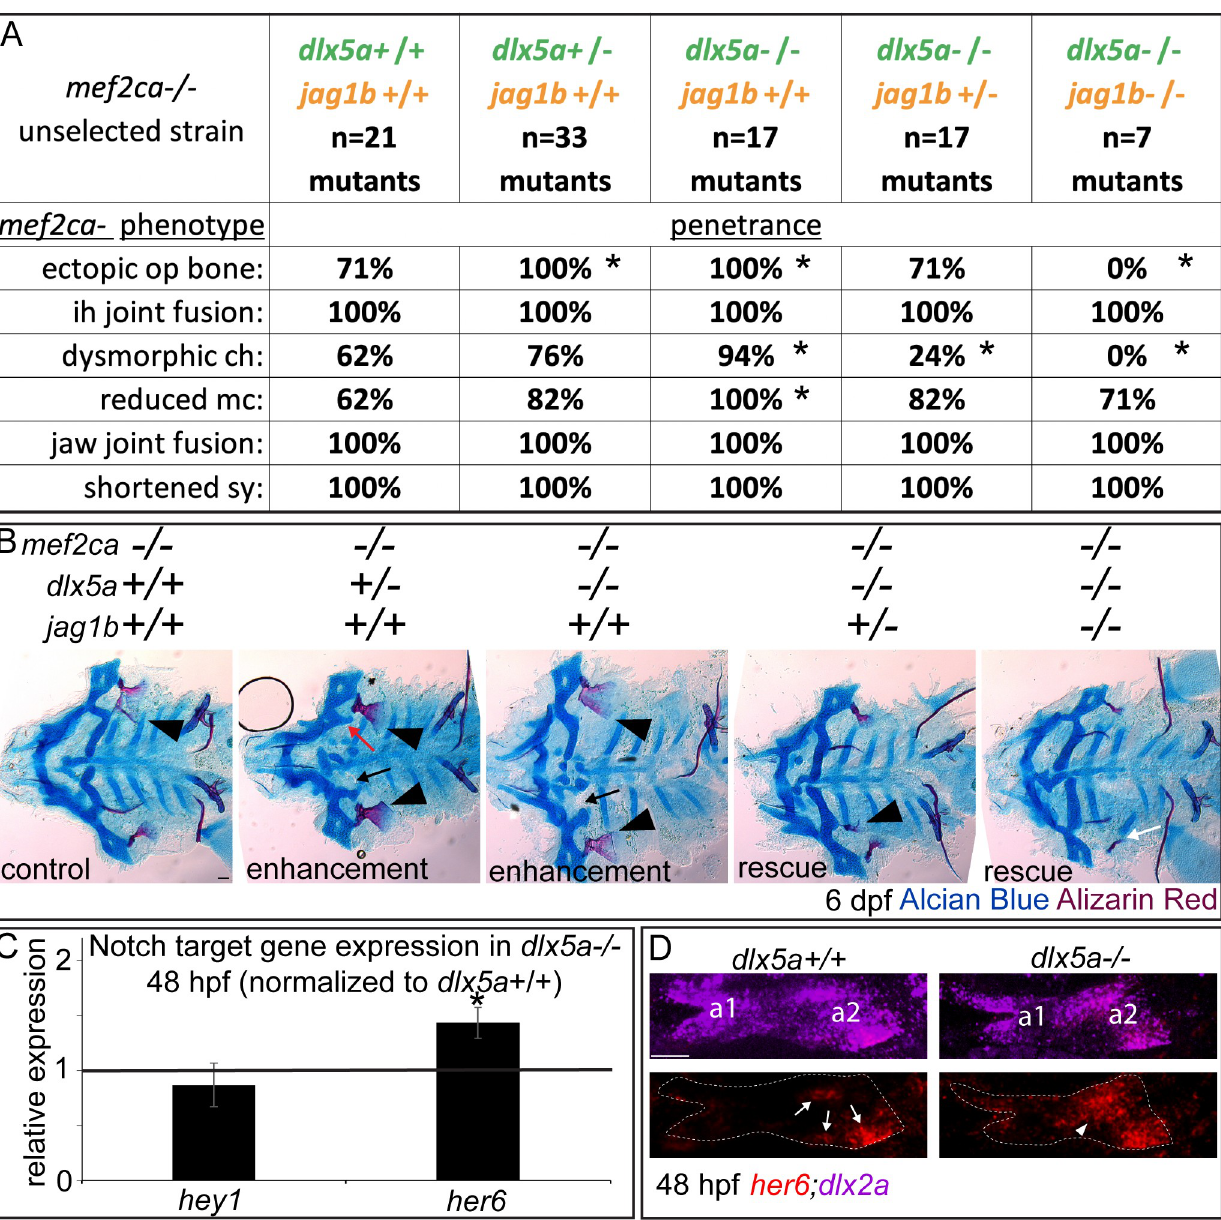
PLOS Genetics | https://doi.org/10.1371/journal.pgen.1008507 December 2,